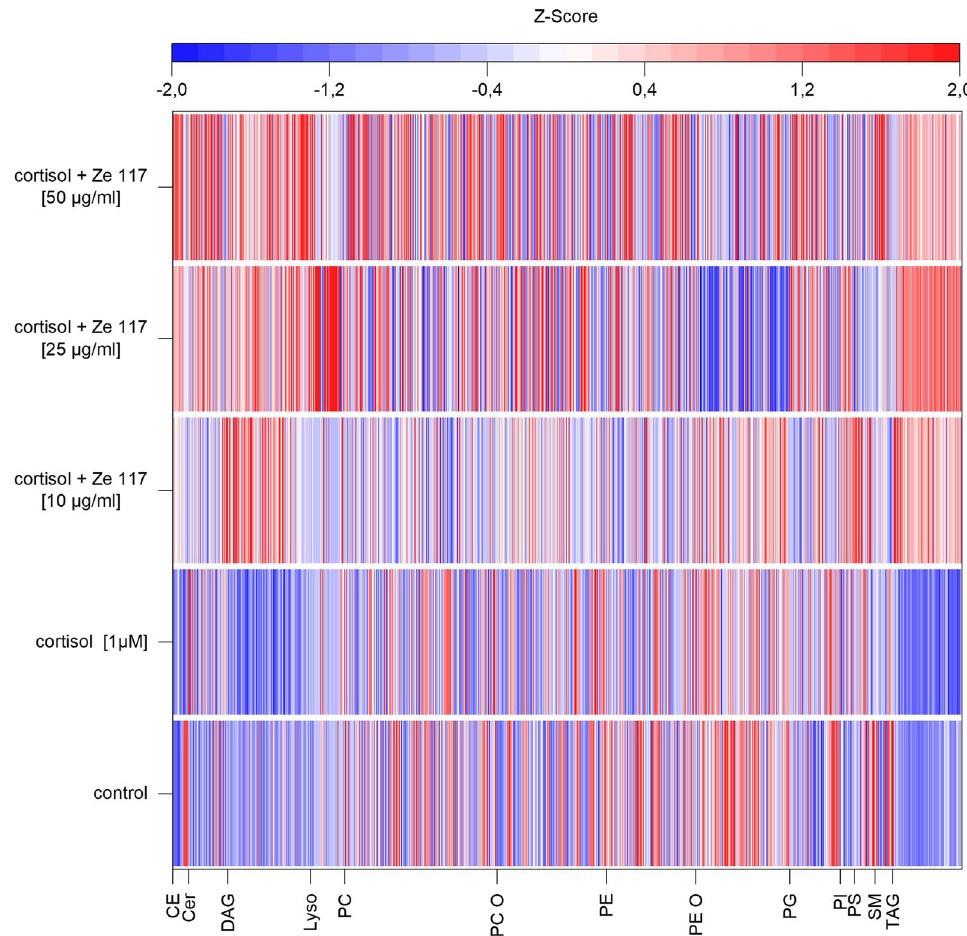
Fig. 3 Heatmap of z-scores of all analysed 890 lipid species calculated from average mol%-values generated by lipidomics. Main lipid classes are given on the x-axis ( CE cholesteryl ester, Cer ceramides, DAG diacylglycerols, Lyso lyso-phospholipids, PC phophatidylcholines, PC O phosphatidylcholine ethers, PE phosphatidylethanolamines, PE O phosphatidylethanolamine ethers, PG phosphatidylglycerol, PI phosphatidylinositol, PS phosphatidylserine, SM sphingomyelin, TAG